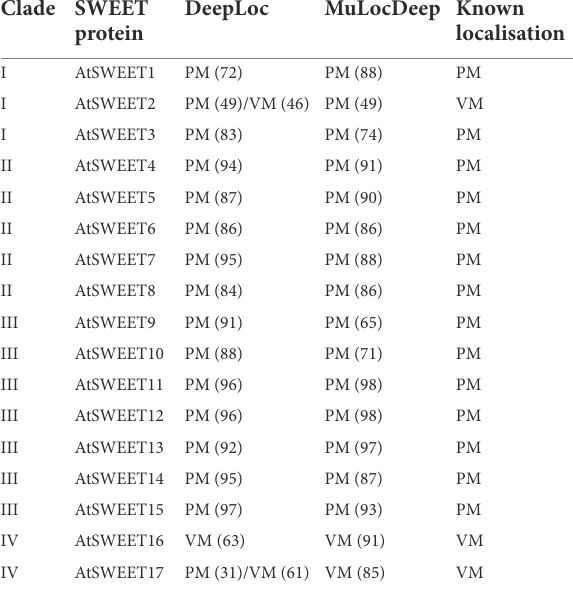
TABLE 3 Subcellular localisation predictions and known location comparisons of Clade I to IV Arabidopsis thaliana SWEETs. Clade SWEET DeepLoc MuLocDeep Known protein